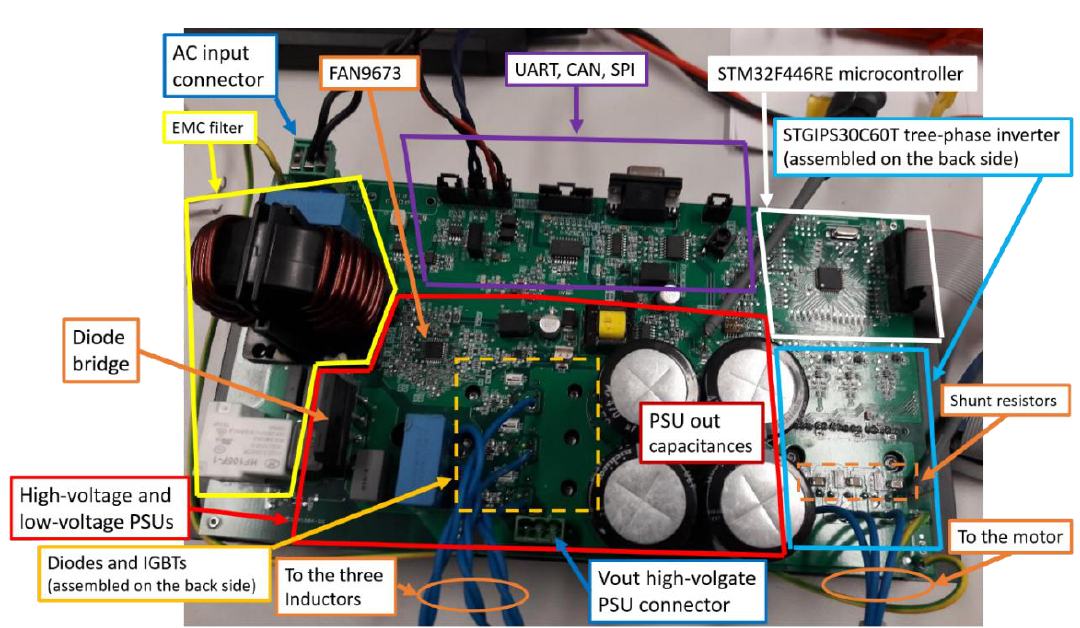
Figure 4. The different subsystems on the printed circuit board (PCB).